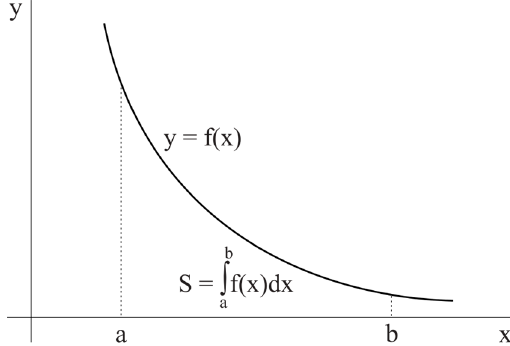
Figure 1. Surface S confined by continuous curve y = f(x) , x ‐ axis, and vertical lines x = a and x = b .